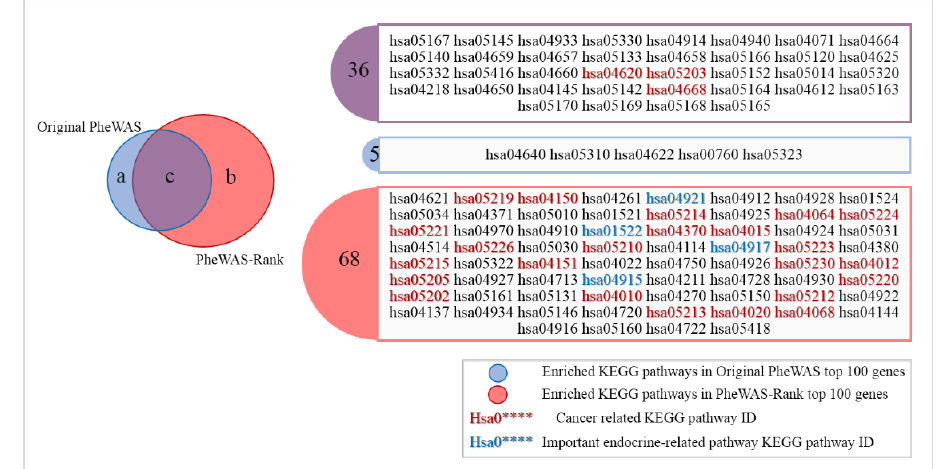
Figure 3. KEGG functional analysis on the top 100 genes of the original PheWAS-derived gene list (Table S1) and the PheWAS-Rank gene list (Table S4) ( p .adjust < 0.05) (Table S6). The PheWAS gene set enriched 41 KEGG pathways ( a , c ); the PheWAS-Rank gene set enriched 104 KEGG pathways ( b , c ); there were 36 KEGG pathways that were enriched in both of the gene lists ( c ). KEGG: Kyoto Encyclopedia of Genes and Genomes.